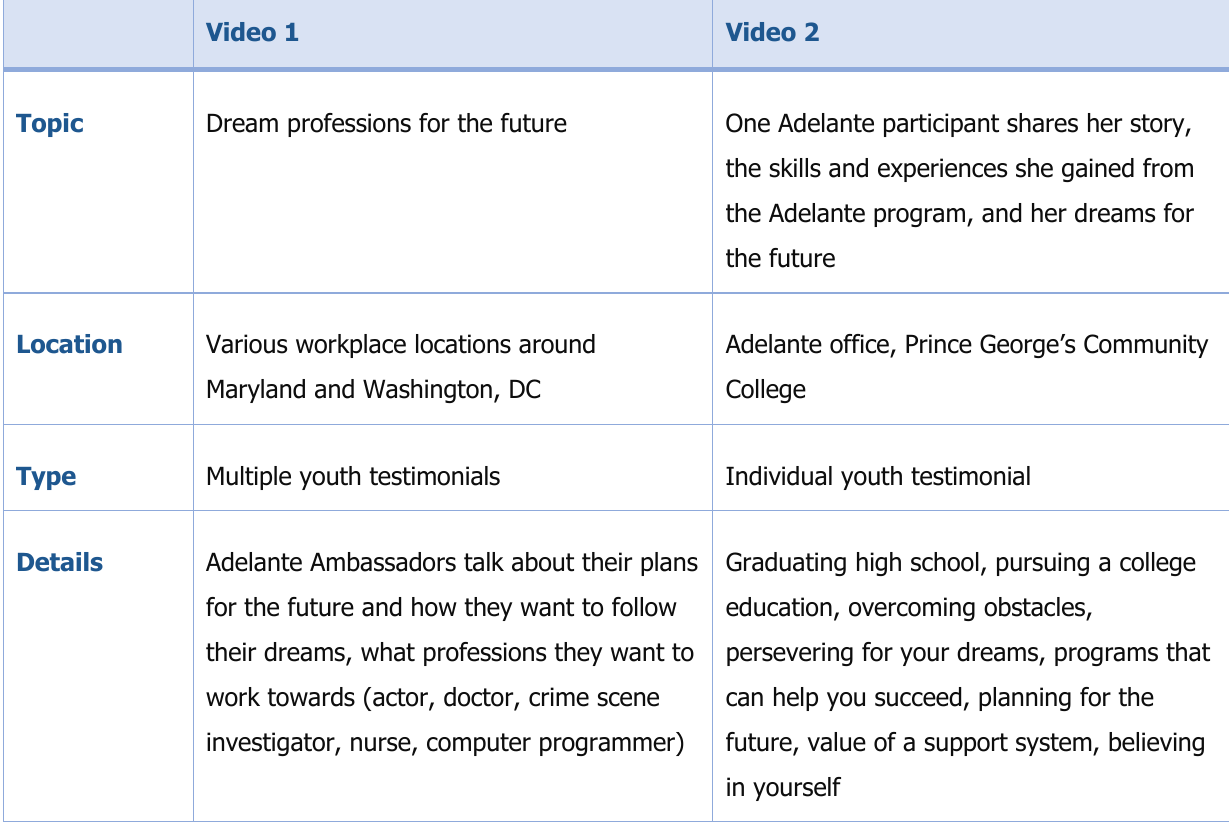
Table 3. Details for Adelante Ambassadors Videos with the Theme: Live Your